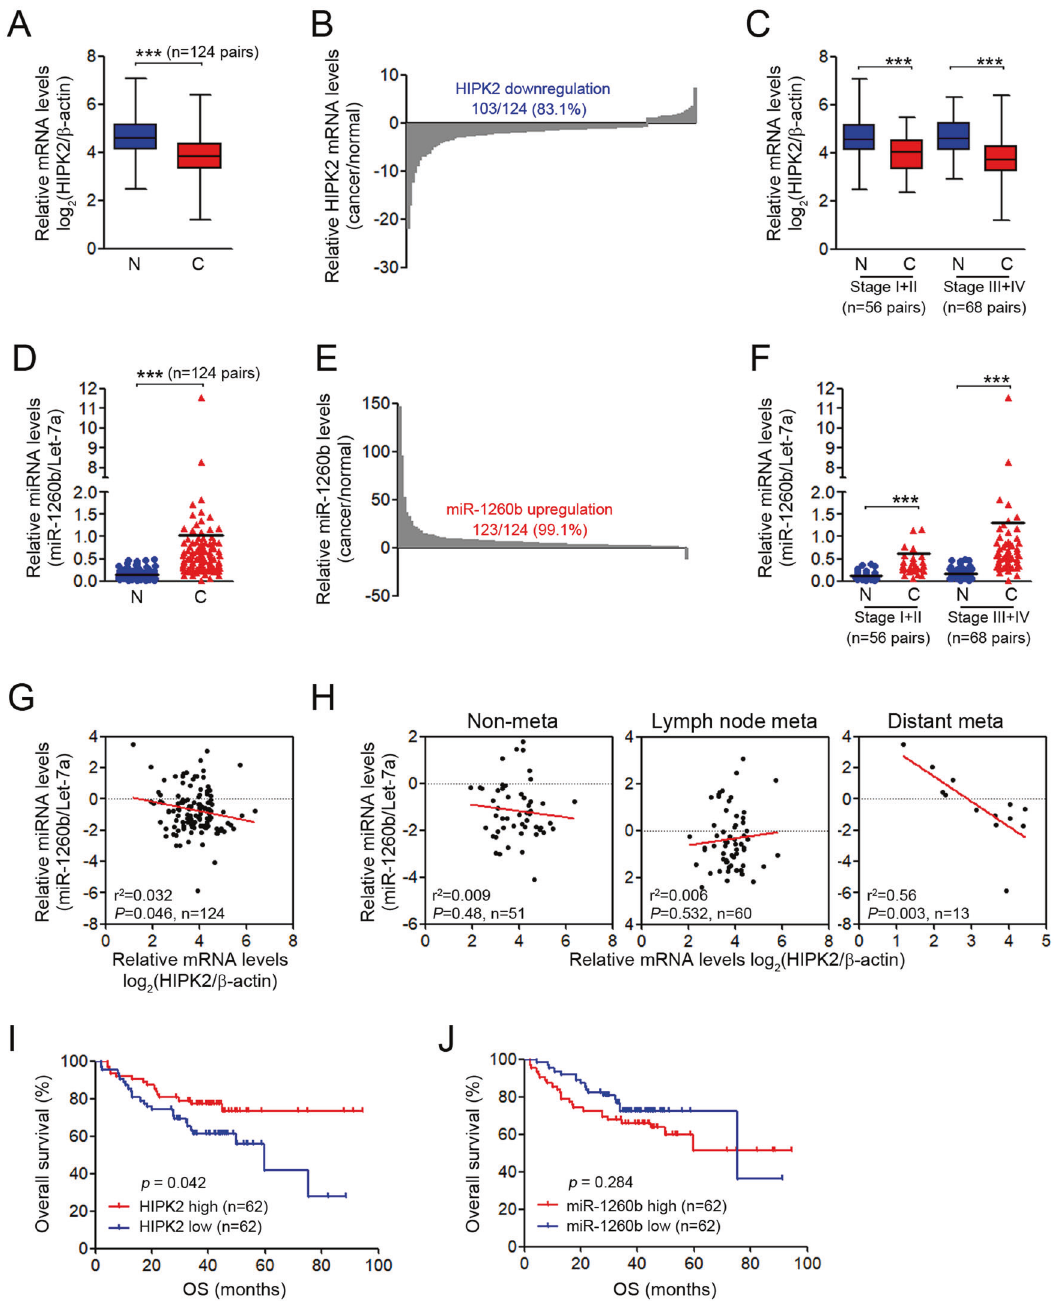
Fig. 4 Relationship between HIPK2 and miR-1260b expression in NSCLC tissues. Expression levels of miR-1260b and HIPK2 were determined by qRT-PCR assay in 124 pairs of NSCLC and adjacent normal tissue samples. A Box plot expression of HIPK2 mRNA levels in paired NSCLC samples. B Fold change in HIPK2 mRNA in 124 cancer tissues divided by that in paired adjacent normal tissues. C Comparisons of HIPK2 mRNA expression at different pathological stages. D Dot plot of miR-1260b expression in paired NSCLC samples. E Fold change in miR-1260b in 124 cancer tissues divided by that in paired normal tissues. F Comparisons of miR-1260b expression at different pathological stages. G Scatter plot showing the correlation between HIPK2 mRNA and miR-1260b expression in tumor samples and H each TNM subset. I , J Kaplan – Meier survival curve according to the categories of low and high expression of HIPK2 mRNA and miR-1260b. *** P < indicator than cellular miR-1260b as a prognostic indicator or predictor of metastasis in NSCLC. DISCUSSION EVs including exosomes are important players in intercellular